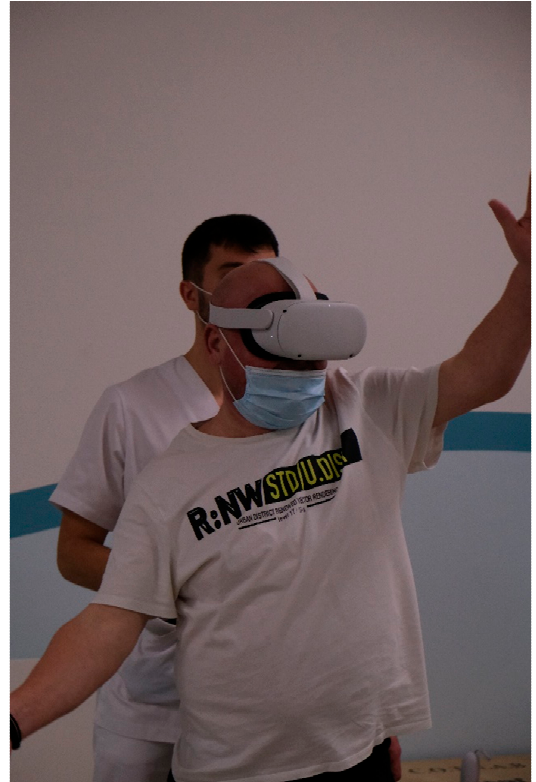
Figure 3. Patient during a VR session.